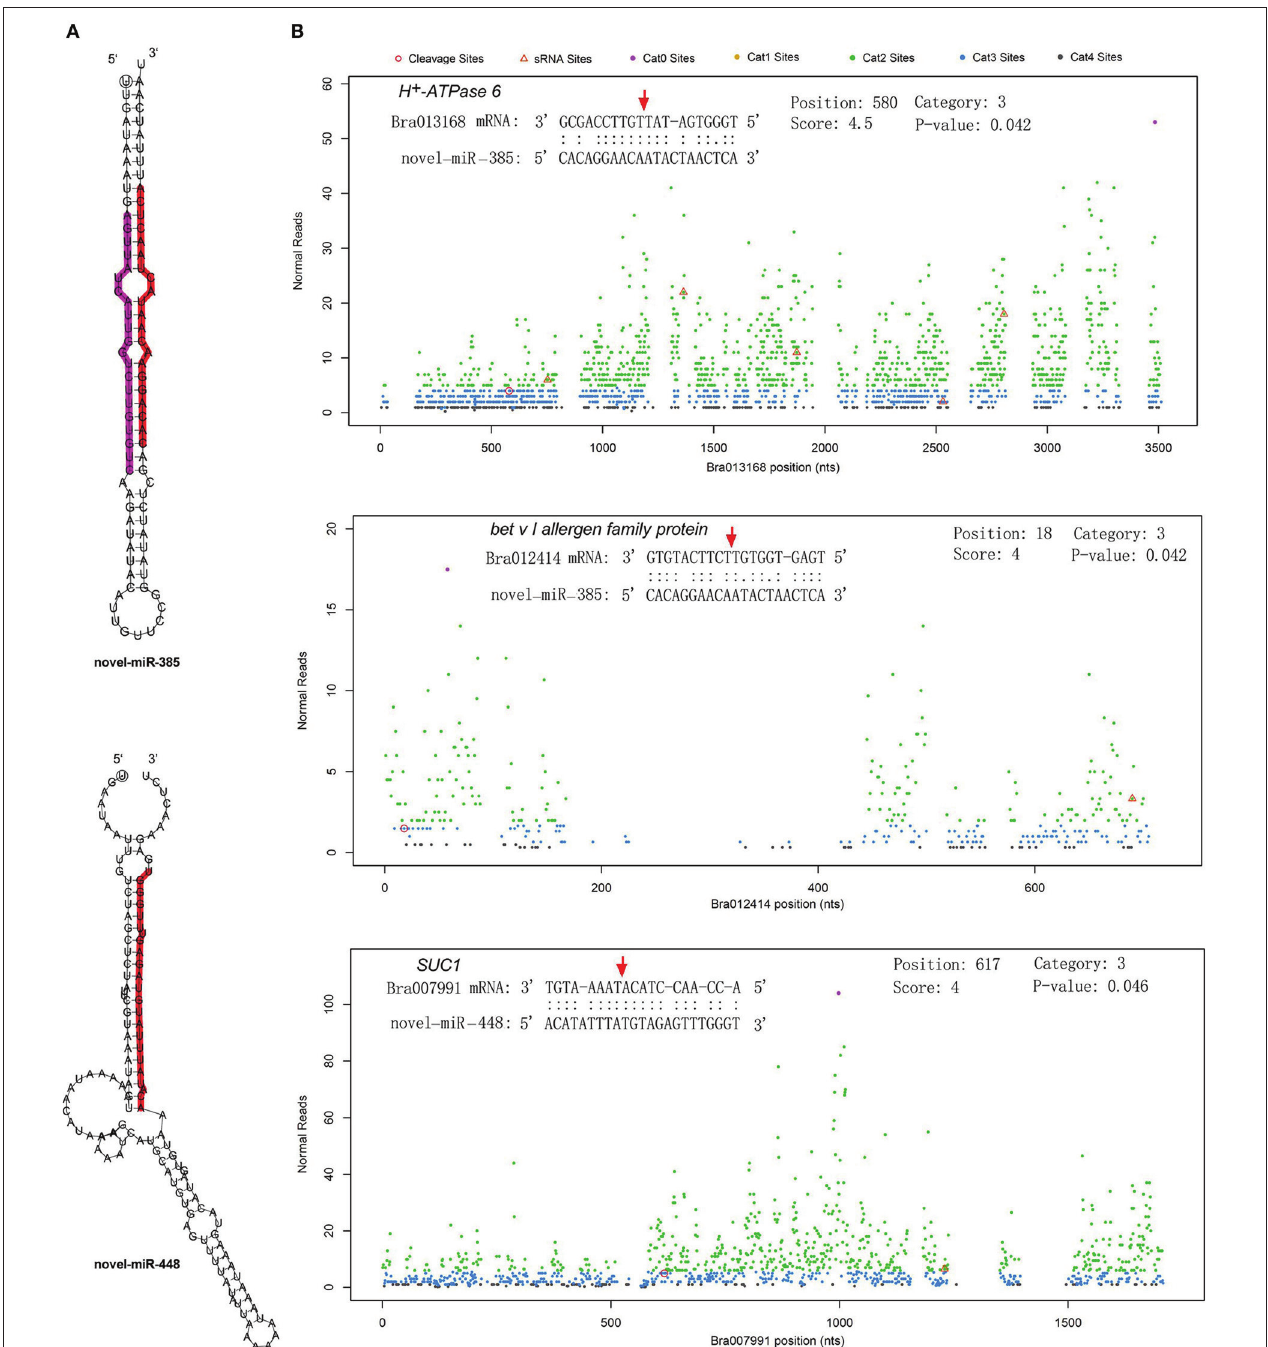
FIGURE 6 | Secondary structure of two novel miRNAs and the cleavage plots of their targets. (A) Secondary structure of pre-miRNA hairpins. Red shaded areas indicate the dominant mature miRNAs, violet shaded areas indicates the reverse complementary mature miRNAs. (B) Cutting plots of miRNA targets confirmed using degradome sequencing. The corresponding miRNA:mRNA alignments are shown on the top. The red arrows indicate the miRNA-directed cleavage positions. The y-axis shows the nucleotide position in the target gene. The x-axis indicates the number of cleaved ends detected in the degradome analysis.